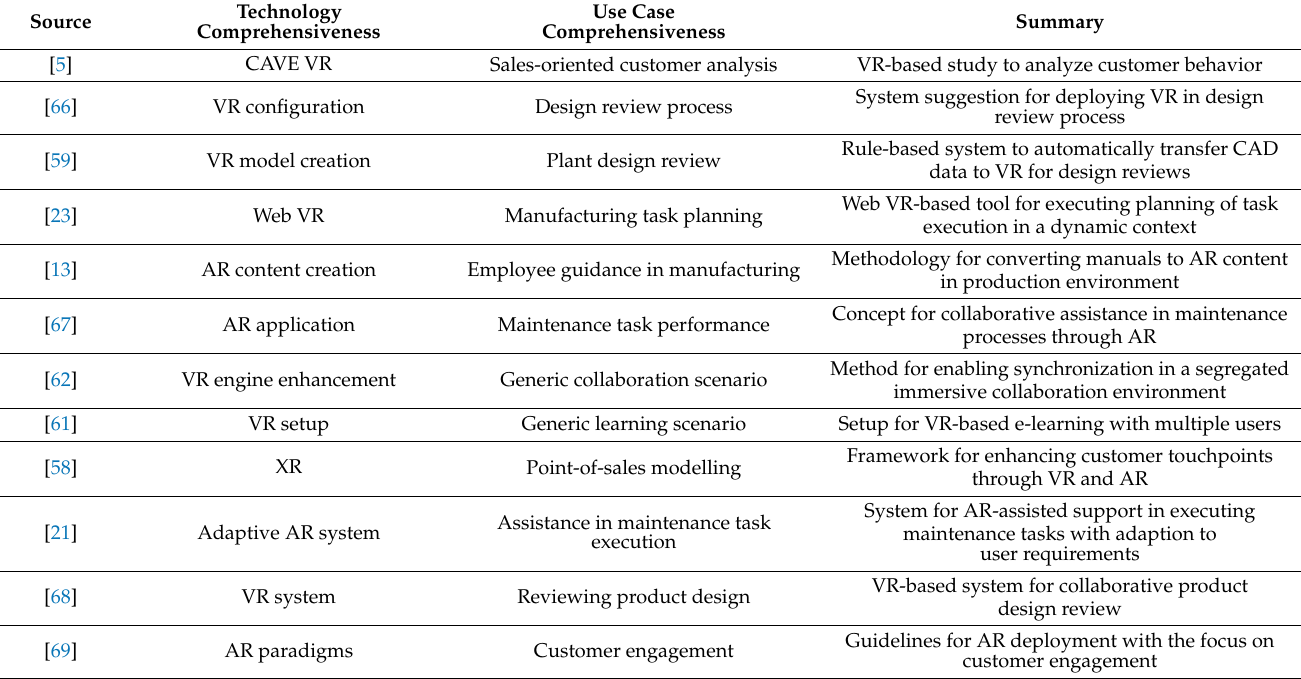
Table 2. Implementation reports on XR Technologies in value